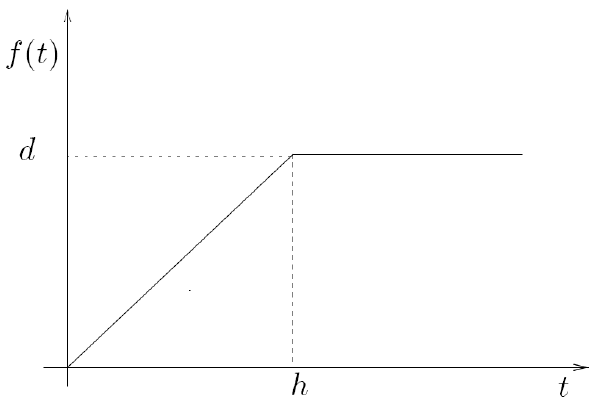
Figure 3. A piecewise linear function used to illustrate the difference between the L 1 norm total variation regularization and the L 2 norm Tikhonov regularization.